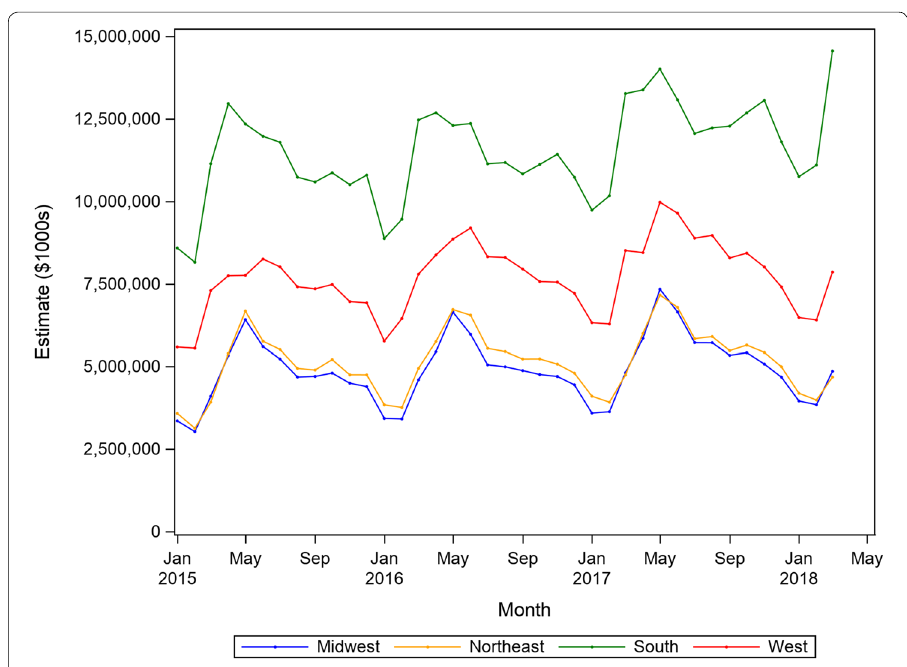
Fig. 6 Regional estimates of retail sales over time for NAICS 444 (building material and garden equipment and supplies dealers)